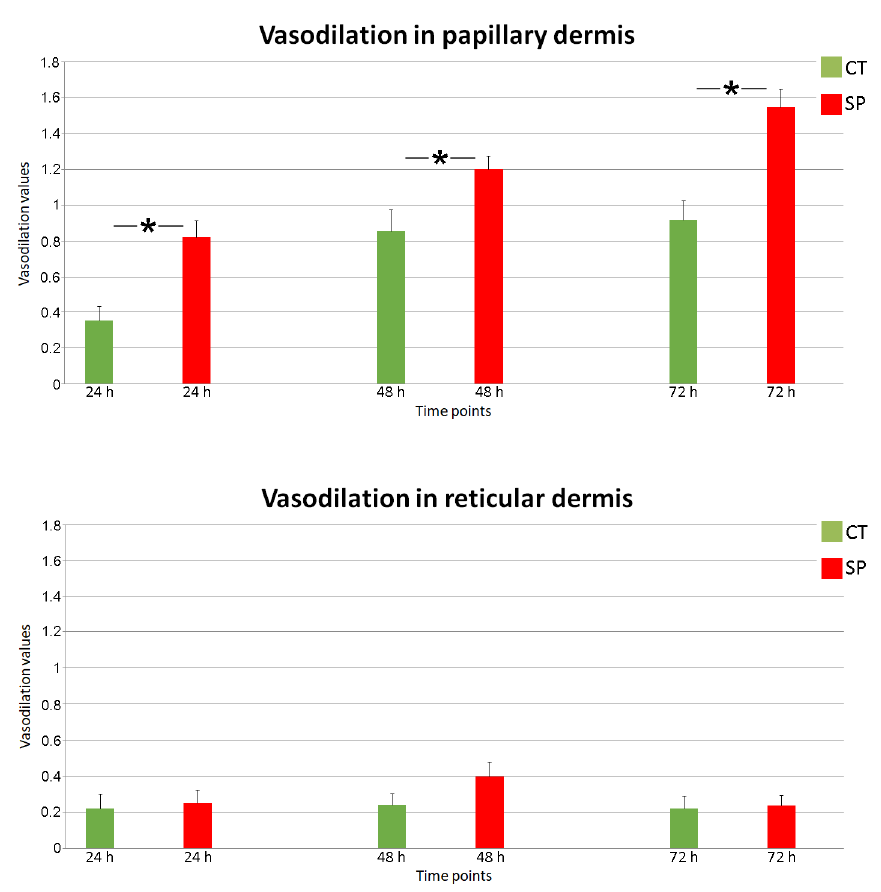
Figure 11. Mean ± standard error values of vasodilation in papillary and reticular dermis. Asterisks indicate significant difference (24 h CT vs. 24 h SP, p < 0.001; 48 h CT vs. 48 h SP, p < 0.007; 72 h CT vs. 72 h SP, p < 0.001). CT, control (untreated); SP, substance P-treated.